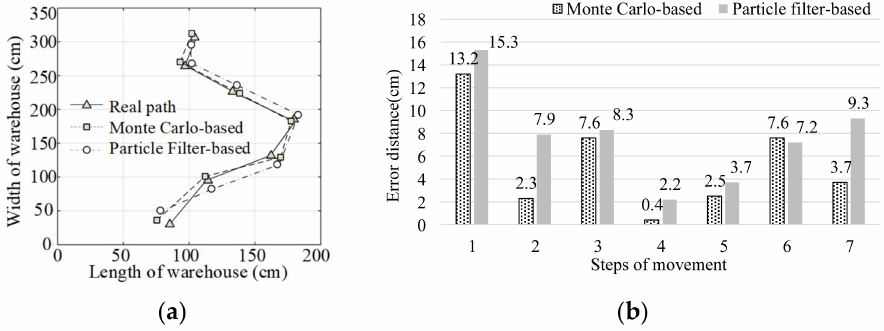
Figure 8. Simulation-based positioning results ( a ) and positioning errors ( b ) when the particle filter-based algorithm uses one large footprint with a radius of 128